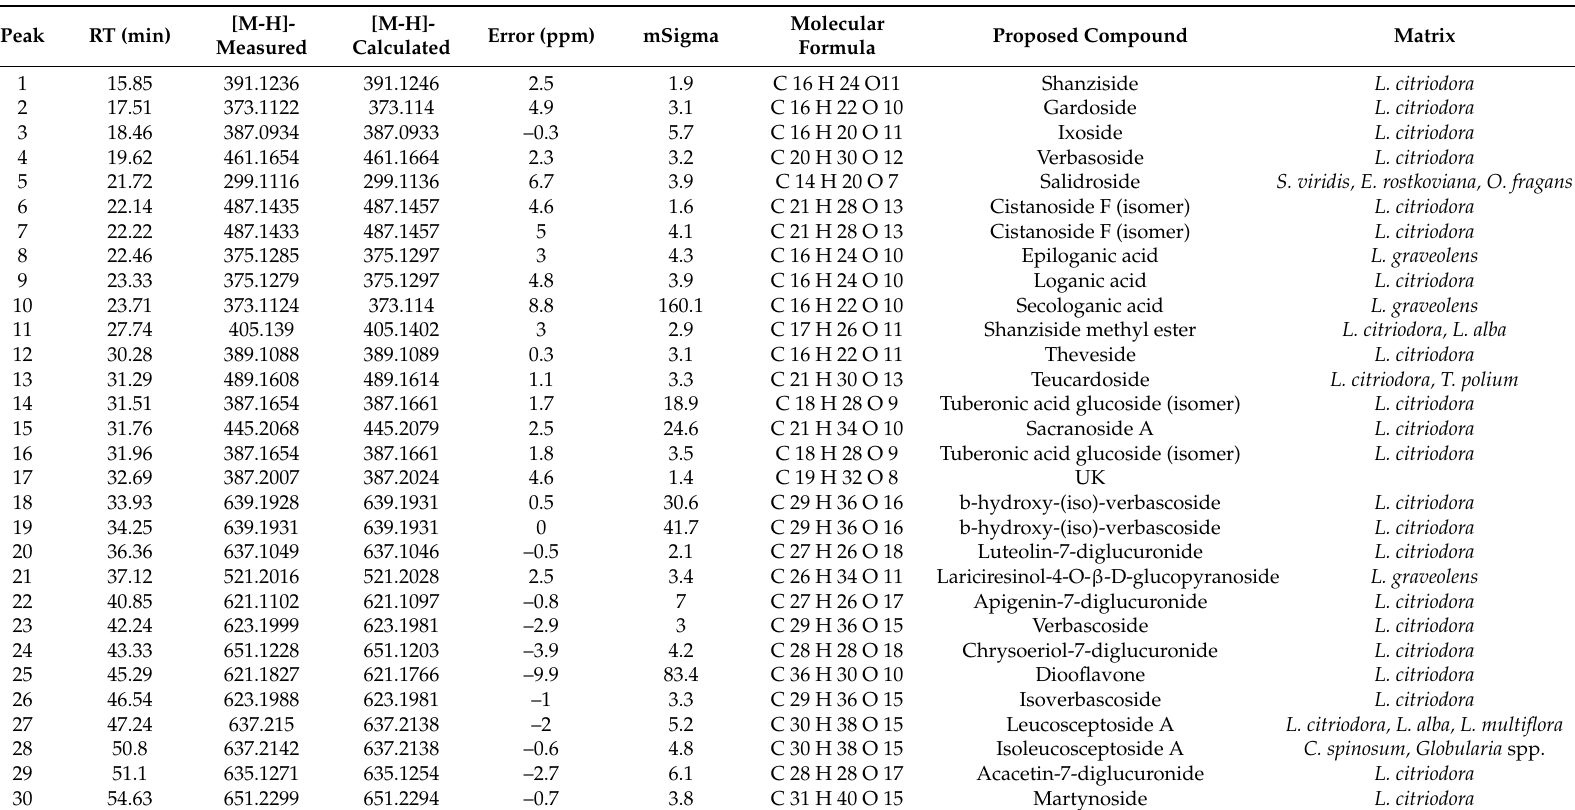
Table 1. Retention time (RT) and mass spectral data of the compounds characterized in the commercial lemon verbena extract (PLX ® 10) by reversed phase (RP)-HPLC-ESI-TOF-MS in negative